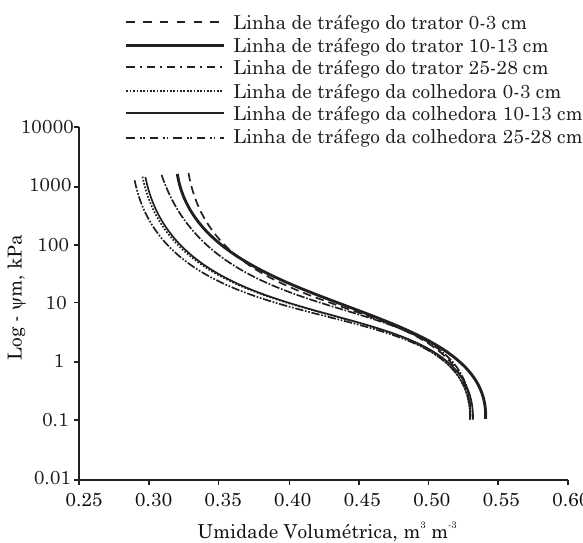
Figura 1. Curva de retenção de água do solo na linha de tráfego do trator e colhedora em três camadas, num Latossolo Vermelho-Amarelo cultivado com café.